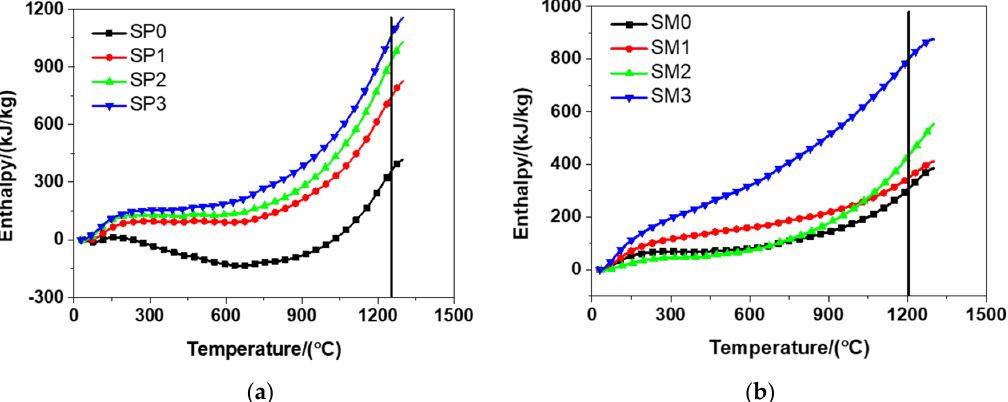
Figure 13. The enthalpy and decomposition enthalpy of siliceous sacrificial cement paste and mortar: ( a ) siliceous sacrificial cement paste; ( b ) siliceous sacrificial mortar. ( a ) siliceous sacrificial cement paste; ( b ) siliceous sacrificial